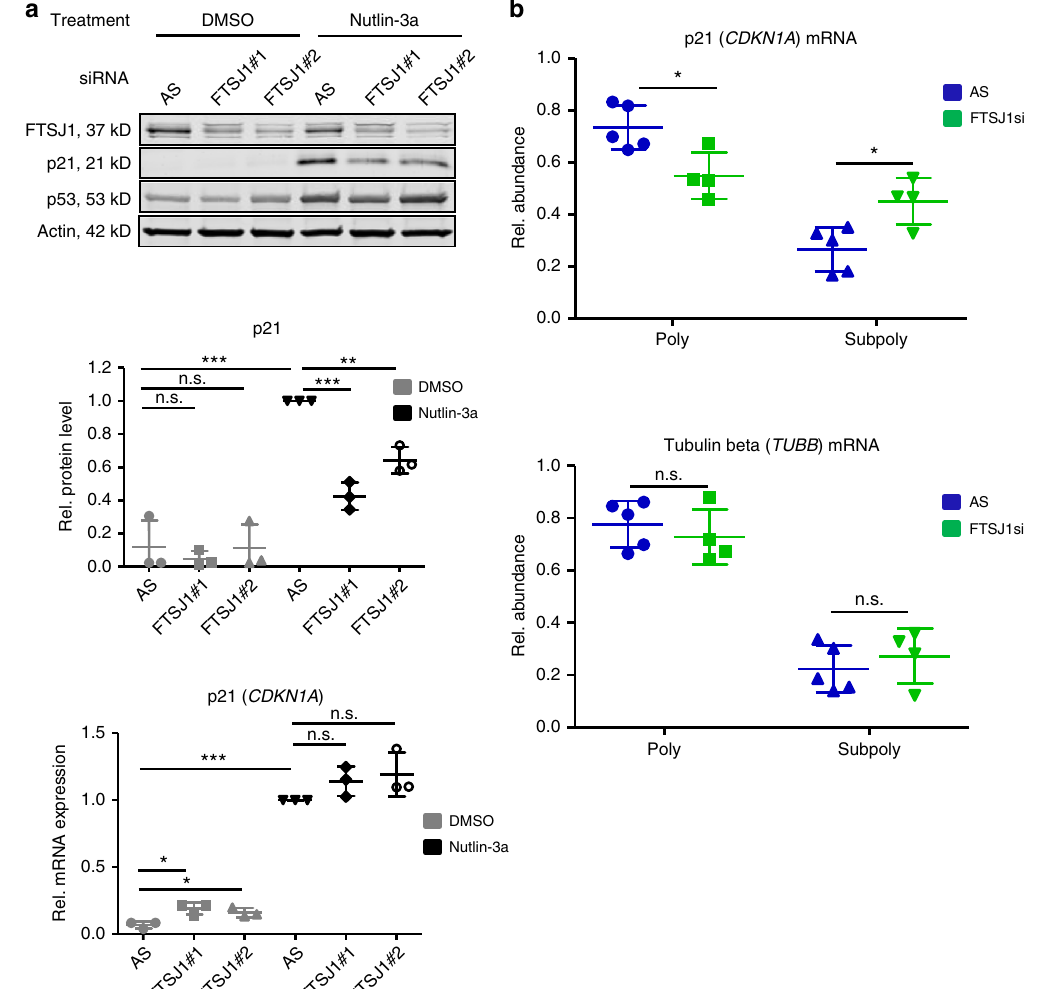
Fig. 4 FTSJ1 knockdown phenocopies Nup155 depletion. a Upper panel: HepG2 cells were treated either with control siRNA (AS) or two FTSJ1 siRNAs (FTSJ#1 and FTSJ1#2) for 72 h and p53 was induced by adding Nutlin-3a for 24 h. Cell extracts were analysed by immunoblotting with indicated antibodies. Middle panel: densitometric quanti fi cation analyses of p21 immunoblots derived from three independent experiments normalised to the Nutlin-3a control siRNA condition. For densitometric analyses of FTSJ1 and p53 see Supplementary Figure 4 A. Lower panel: relative p21 ( CDKN1A ) mRNA levels of the corresponding conditions described above were measured by qRT-PCR. Data are derived from three independent experiments and normalised to the Nutlin-3a control siRNA condition. b HepG2 cells were treated either with control siRNA (AS) or two different FTSJ1 siRNAs (FTSJ1#1 and FTSJ1#2) for 72 h. Polyribosome analyses were performed as described in Fig. 2d. p21 ( CDKN1A ) mRNA (left panel) and tubulin beta ( TUBB ) mRNA (right panel) of the polysomal (poly) and subpolysomal (subpoly) fractions were measured by qRT-PCR with the expression levels normalized to Renilla spike-in RNA. p -values result from the comparison of the control (AS) ( n = 5) and combined FTSJ1 siRNAs ( n = 4). The control siRNA (AS) condition is identical to that shown in Fig. 2d (see also Methods section). * p < 0.05, ** p < 0.01, *** p < 0.001 (Student ′ s t -test); Data are presented as mean ± stdv. Source data are provided as